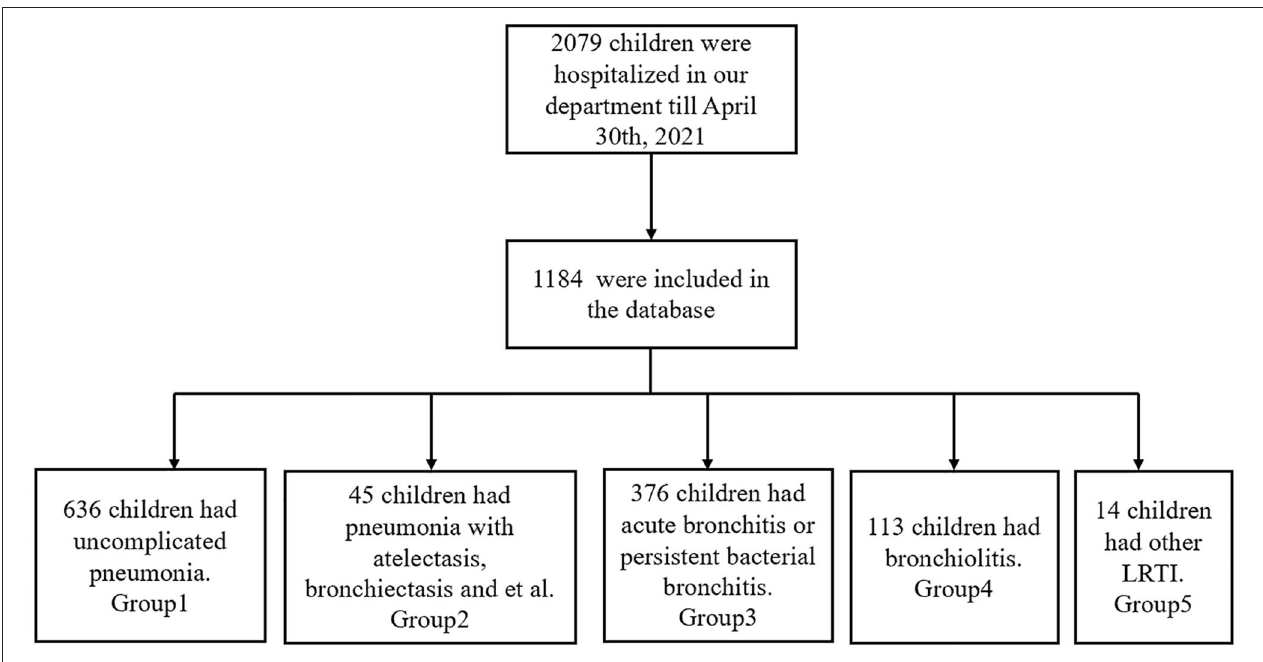
FIGURE 3 | Flow diagram of the selected